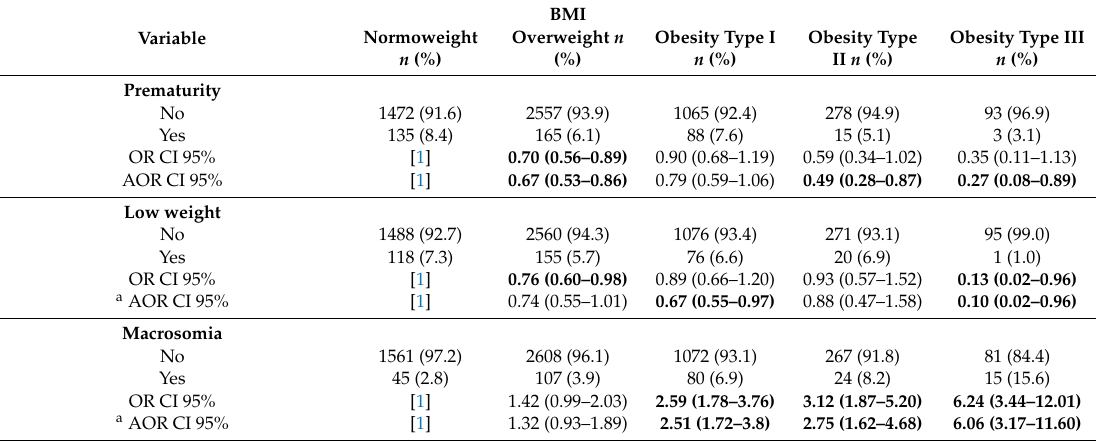
Table 4. Postpartum maternal / fetal complications according to the